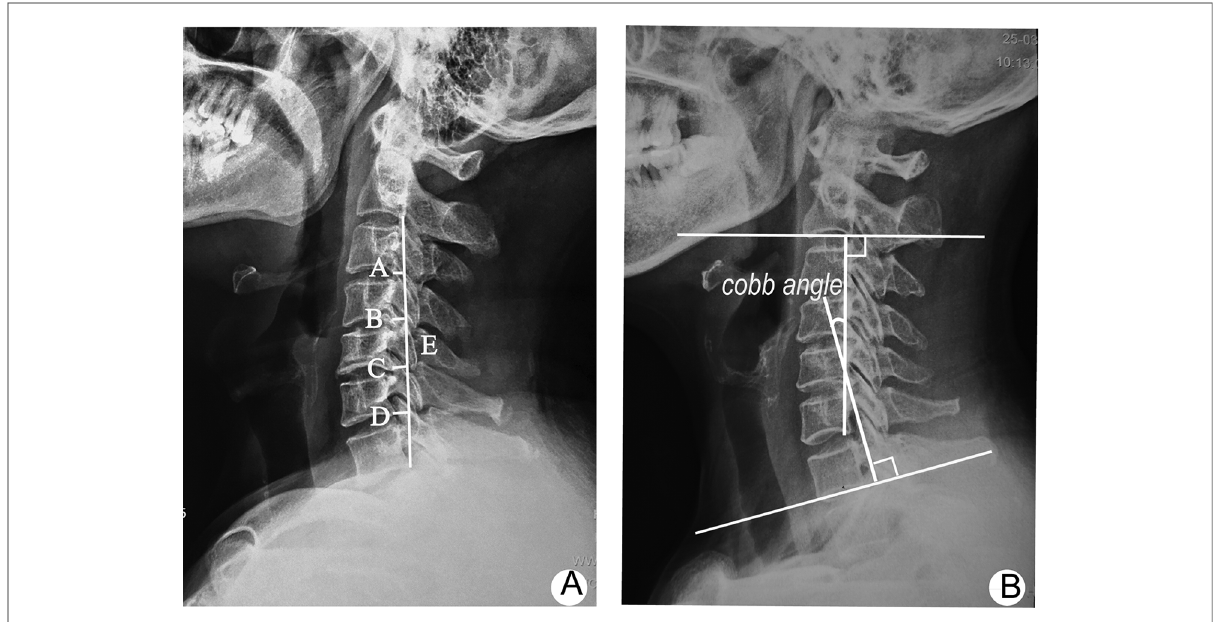
FIGURE 2 Radiological parameters of the cervical spine. ( A ) CCI measures cervical curvature based on the distance from the posteroinferior edge of the C3 – C6 vertebral body to a straight line drawn from the posteroinferior edge of C2 – C7 [CI=(A+B+C+D)/E×100]; ( B ) Cobb angle measures the cervical lordotic angle formed by two lines perpendicular to inferior endplates of the C2 and C7 vertebral bodies, respectively. Cervical range of motion (ROM) was calculated as the difference between the Cobb angles at maximal fl exion and extension on anteroposterior (AP)